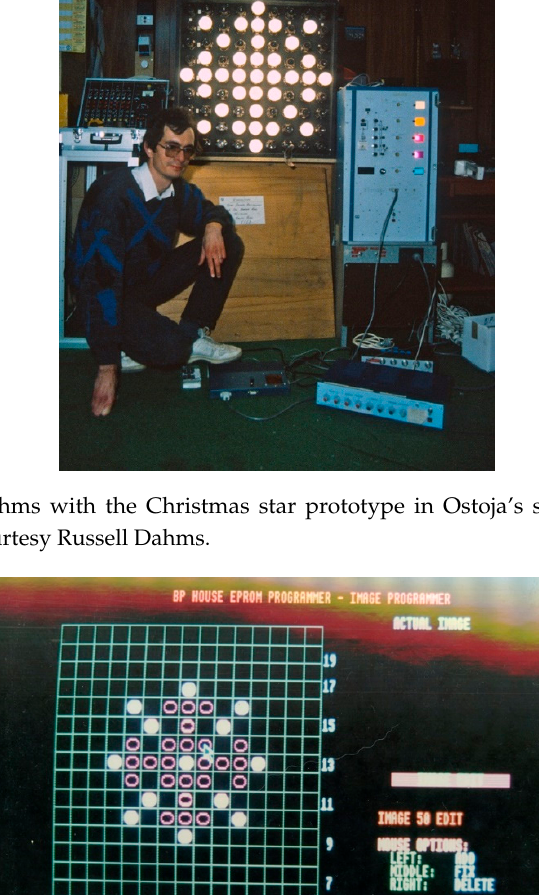
Figure 8. Photograph of a star installed on BP House, St Kilda Rd, Melbourne. We do not know whether it is one of Ostoja’s stars, or not. Mark Strizic, 1976, photograph of the Christmas Star installed on BP House, Melbourne. © the Estate of Mark Strizic. Published with permission. Image courtesy: Pictures Collection, State Library Victoria.